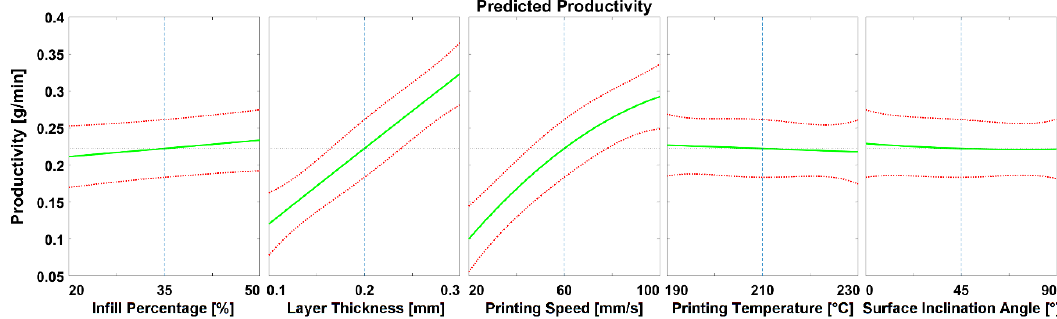
Figure 15. Predicted effects of changes in process parameters on productivity.